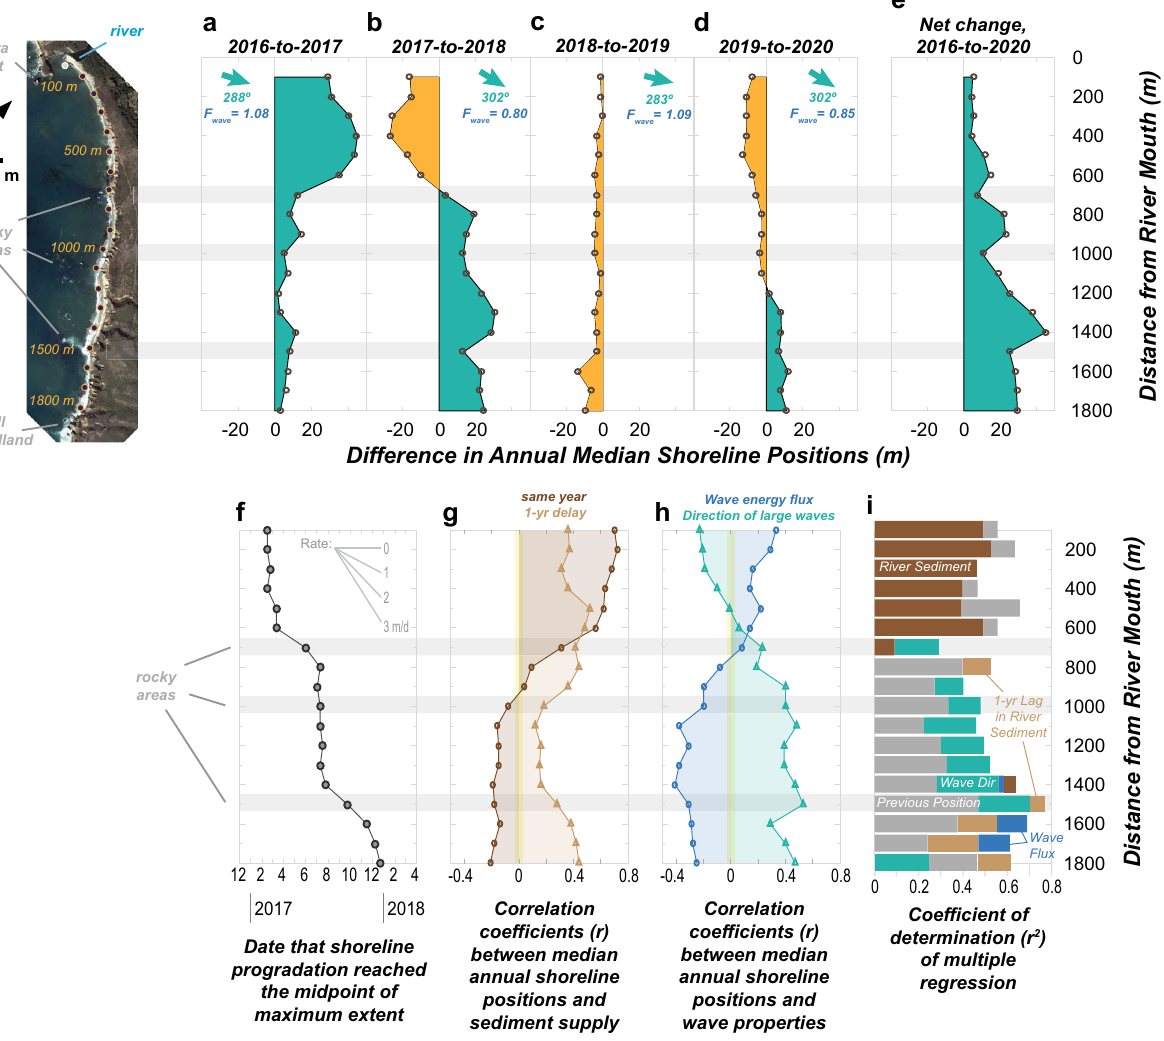
Figure 6. Summary measurements of the shoreline response to the 2016–2017 fire–flood event and the shoreline patterns and regression results from the Big Sur River study site. A rotated map of the study area is shown in the upper left for reference. ( a – d ) Year-to-year differences in the annual median CoastSat shoreline positions showing areas of accretion (green) and erosion (orange). Also shown are the annual wave parameters ( F wave and Dir ; see “Methods”) for the fall-to-winter storm seasons between the two years. ( e ) The net change during 2016–2020 from differences in annual median shoreline positions. ( f ) Timing of the initiation of shoreline accretion as shown by the date for which the shoreline position reached the midpoint of the maximum accretion (see Fig. 3 and “Methods”). ( g – h ) Correlation coefficients ( r ) for single variable regressions between annual median shoreline positions and the log 10 -transformed river sediment discharge values (both the same year and 1-year lagged) and the storm-season wave parameters. ( i ) Stepwise multiple variable regression results showing the total r 2 for the net result (total bar length), the variables contributing significantly to this regression with p < 0.05 (bar colors), and the stepwise total r 2 for each added variable (bar increment